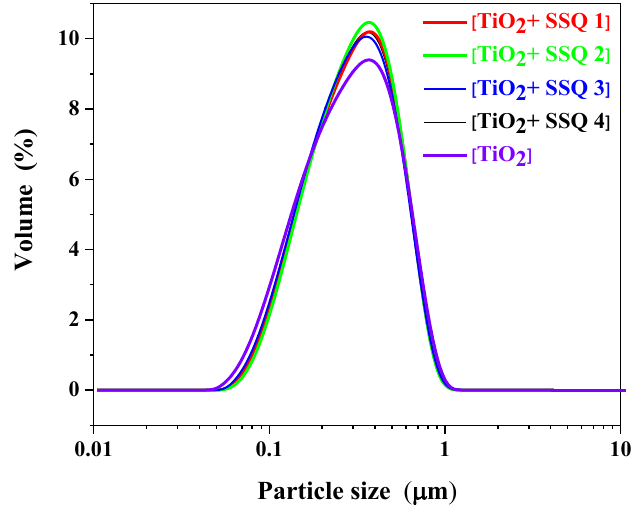
Figure 7. Particle size distribution of nonmodified and modified titanium dioxide. Table 4 presents the data in the form of d (0.1), d (0.5), and d (0.9). The obtained results indicated no meaningful effect of the applied modifiers on the variation in the particle size distribution compared to TiO 2 . Table 4 also shows the results of zeta potential of samples obtained. It was proved that the nonmodified TiO 2 suspension had a positive zeta potential value. These results are in accordance with data recorded by Ridley et al. [33] and Halimi et al. [34]. The modification of titanium dioxide with SSQs changed the surface charge from positive to negative. It should be highlighted that all suspensions can be considered as stable. Based on the literature data, the dispersion with the ζ potential value higher than ± 25 mV is less prone to change their particle size [35].